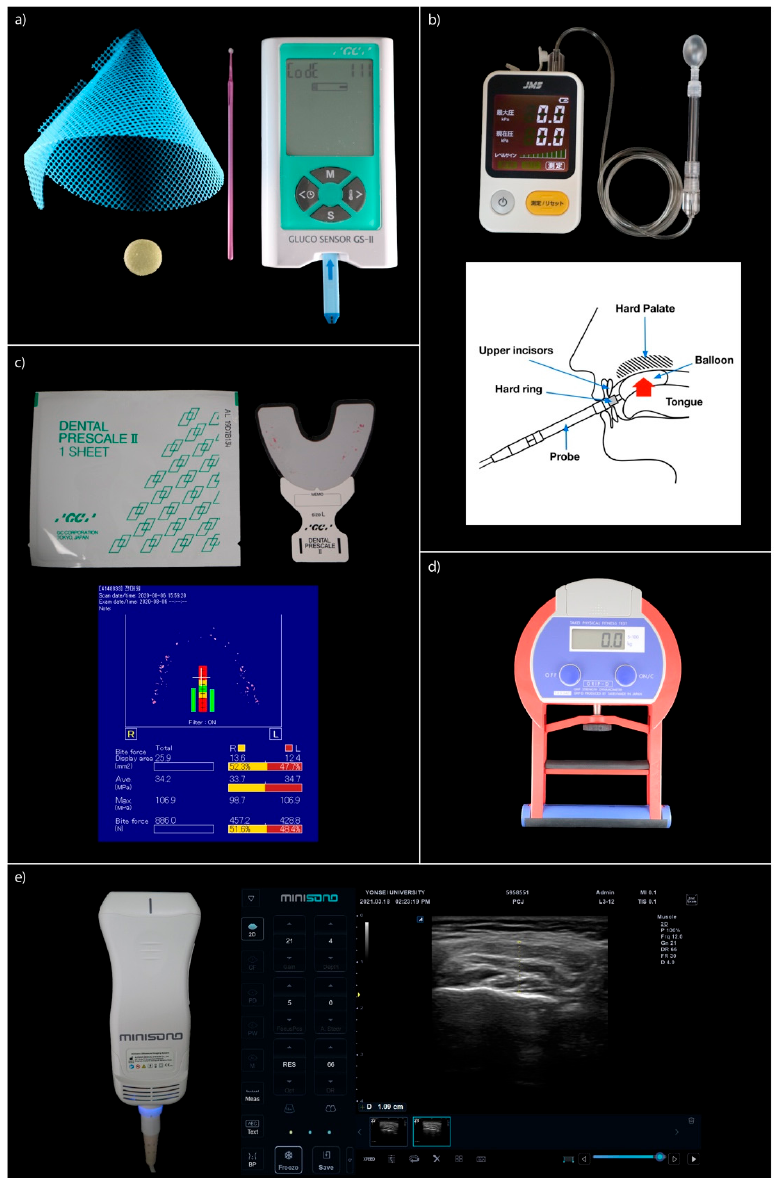
Figure A1. Measuring devices for objective assessment in this study. ( a ) masticatory performance, GS-2. ( b ) tongue pressure, TPM-01 [45]. ( c ) bite force and occluding bite area, Dental Prescale and Occluser software program. ( d ) handgrip strength, Takei handheld dynamometer. ( e ) masseter muscle thickness, Minisono.